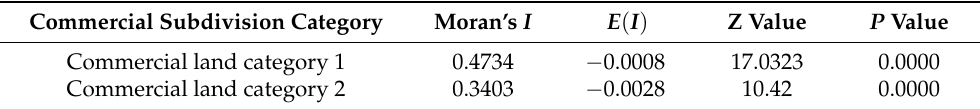
Table 7. Global Moran’s I index estimated by commercial subdivision land prices in the main district of